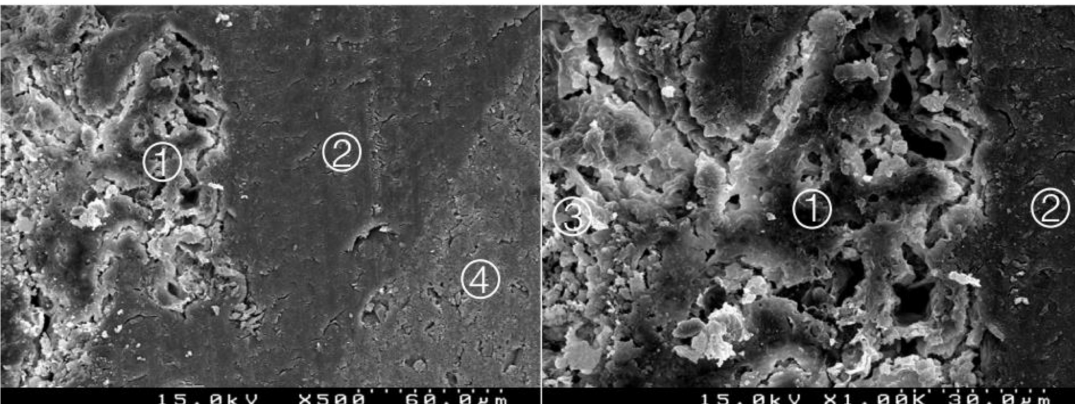
Figure 7. Group 5 (BiodentineU0I): deep interpenetration between the adhesive and the cement, with particles of cement involved by the adhesive. A thick hybrid layer is presented 1 (cid:13) between the adhesive 2 (cid:13) and the Biodentine TM 3 (cid:13) . Composite resin 4 (cid:13) (original magnification 500 × and 1000 × ).